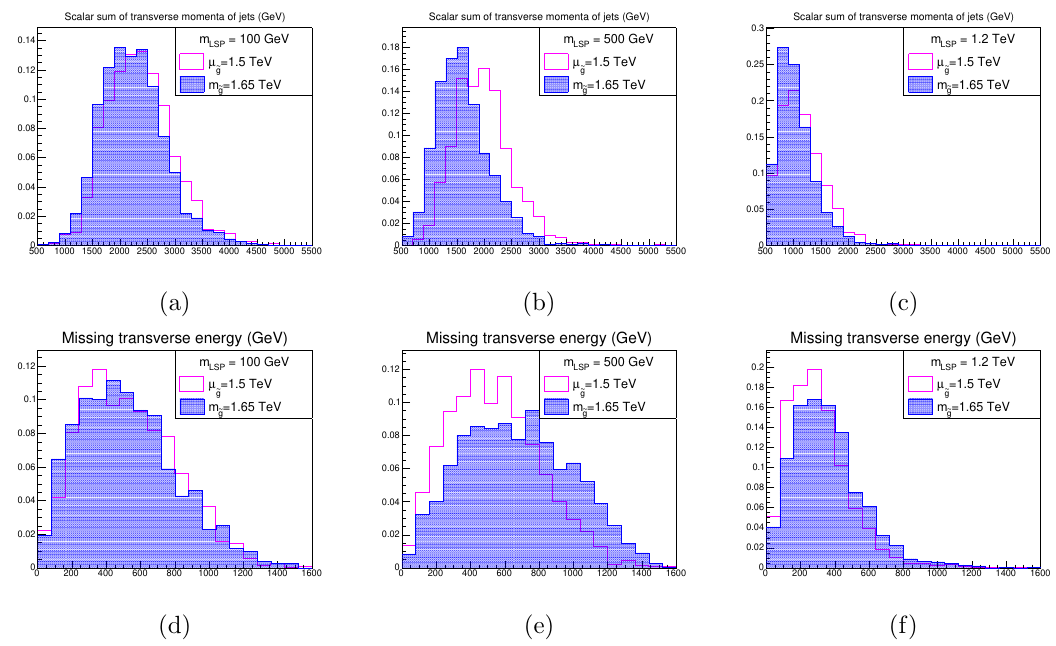
Figure 18. Comparison of MSSM gluino (blue) and gluino continuum (magenta) for di(cid:11)erent masses of LSP at the LHC with 13 TeV. Distributions are all normalized to 1. The chosen bench- marks are an MSSM gluino with a mass of 1.65 TeV and a gluino continuum with (cid:22) g = 1 : 5 TeV, which have equal production cross sections.